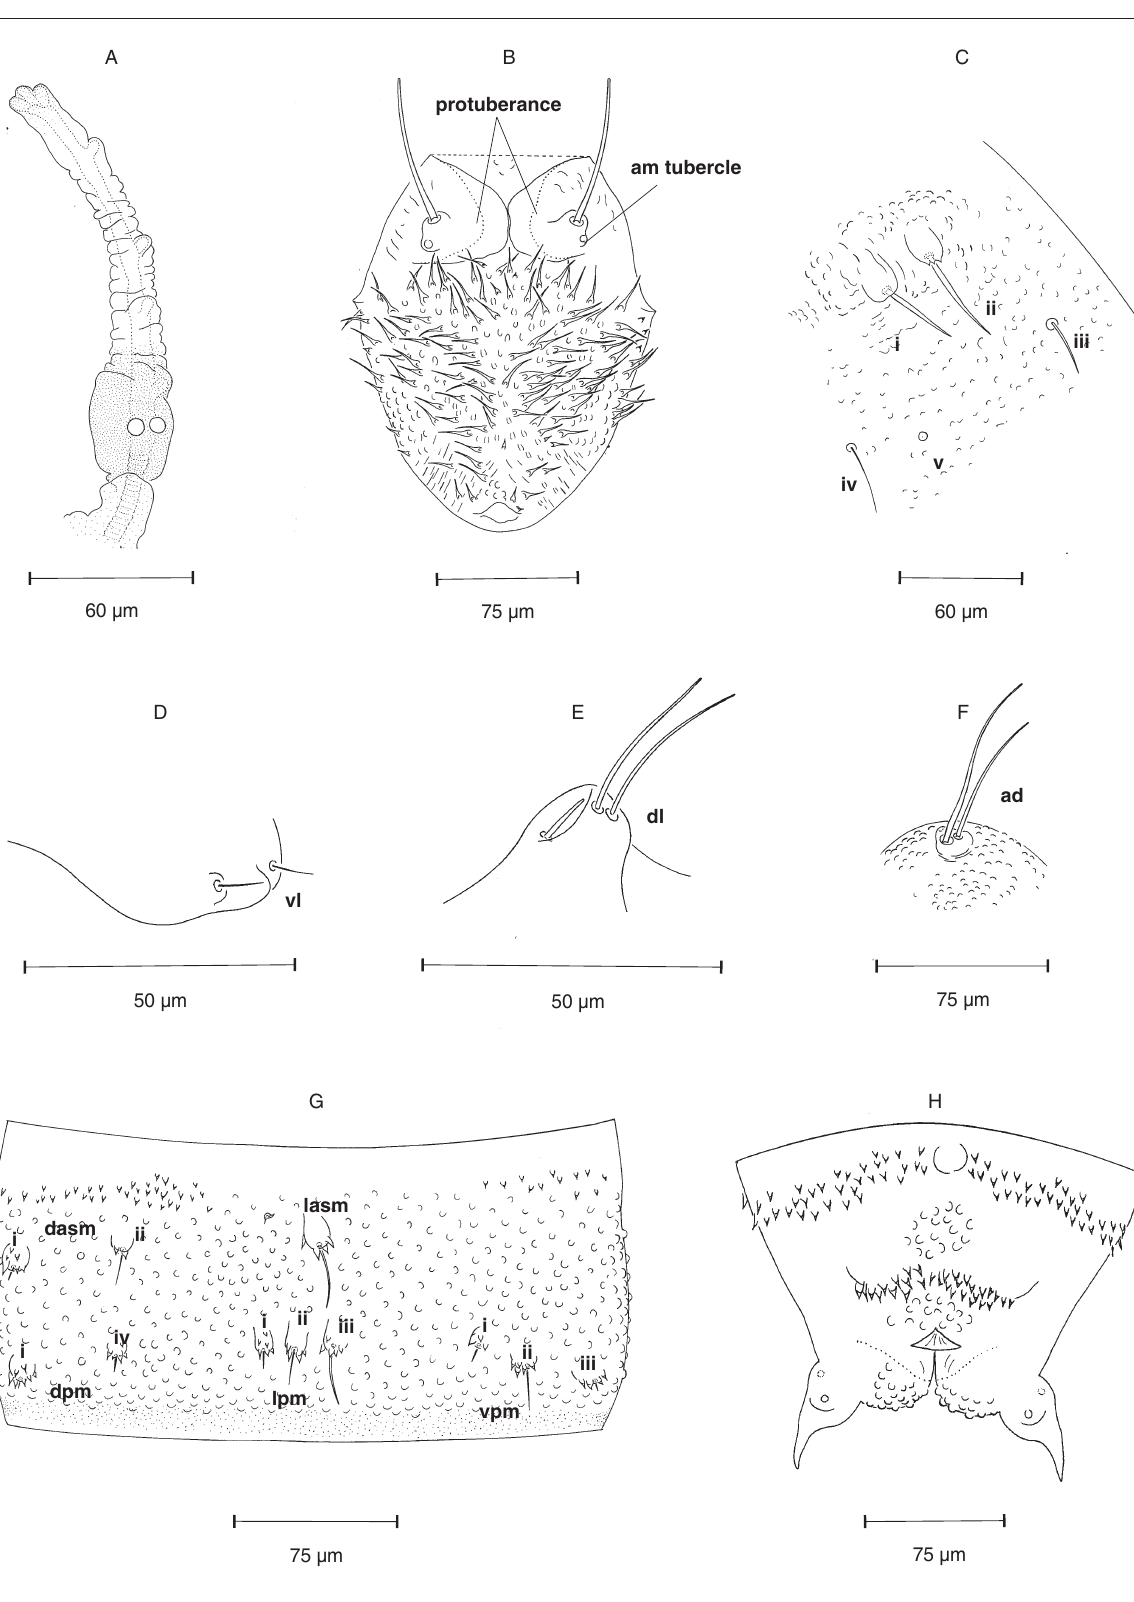
FIG. 2 The pupa of Culicoides sp. # 54 pale form: (A) prothoracic respiratory organ; (B) ♀ operculum; (C) thorax (setae d i – d v); (D) ventrolateral setae (vl); (E) dorsolateral tubercle (dl); (F) anterodorsal tubercle (ad); (G) fourth abdominal segment; (H) caudal